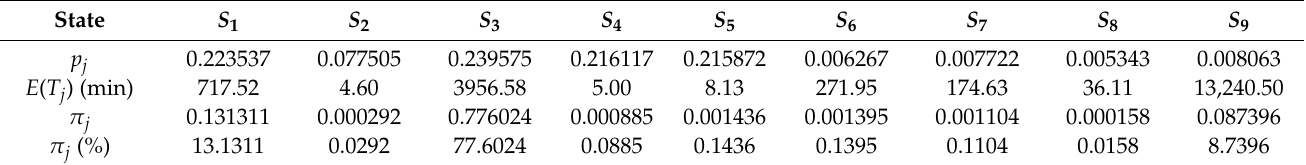
Table 6. Ergodic probabilities of states in embedded Markov chain and